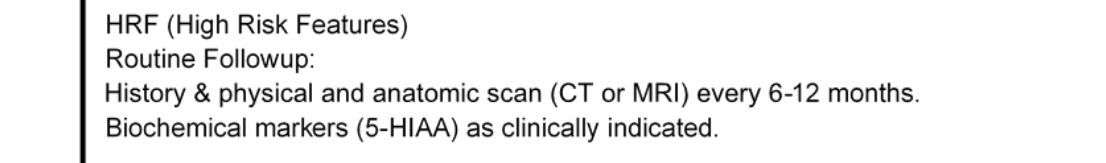
Figure 1. Post-treatment Follow-up After Surgery for Appendiceal Neuroendocrine Neoplasms (ANENs).